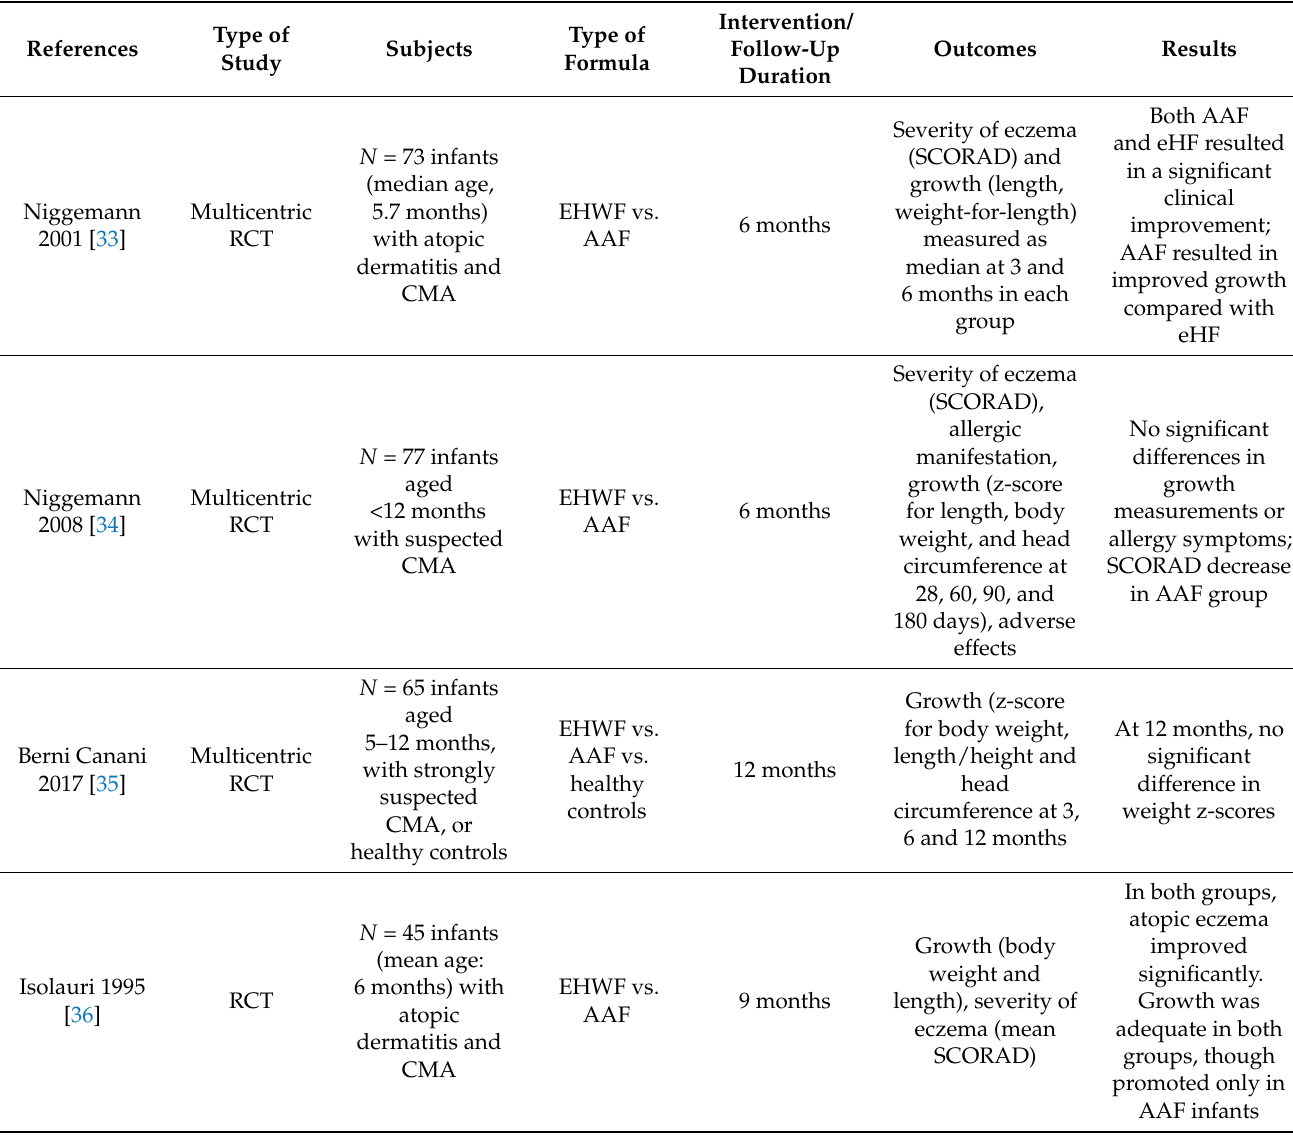
Table 2. Main trials evaluating safety and efficacy of different hydrolysed formulas in the treatment of